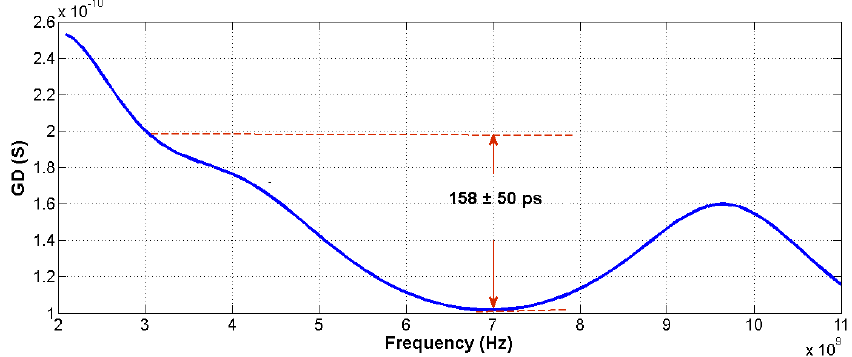
Figure 14. Postlayout simulation of group